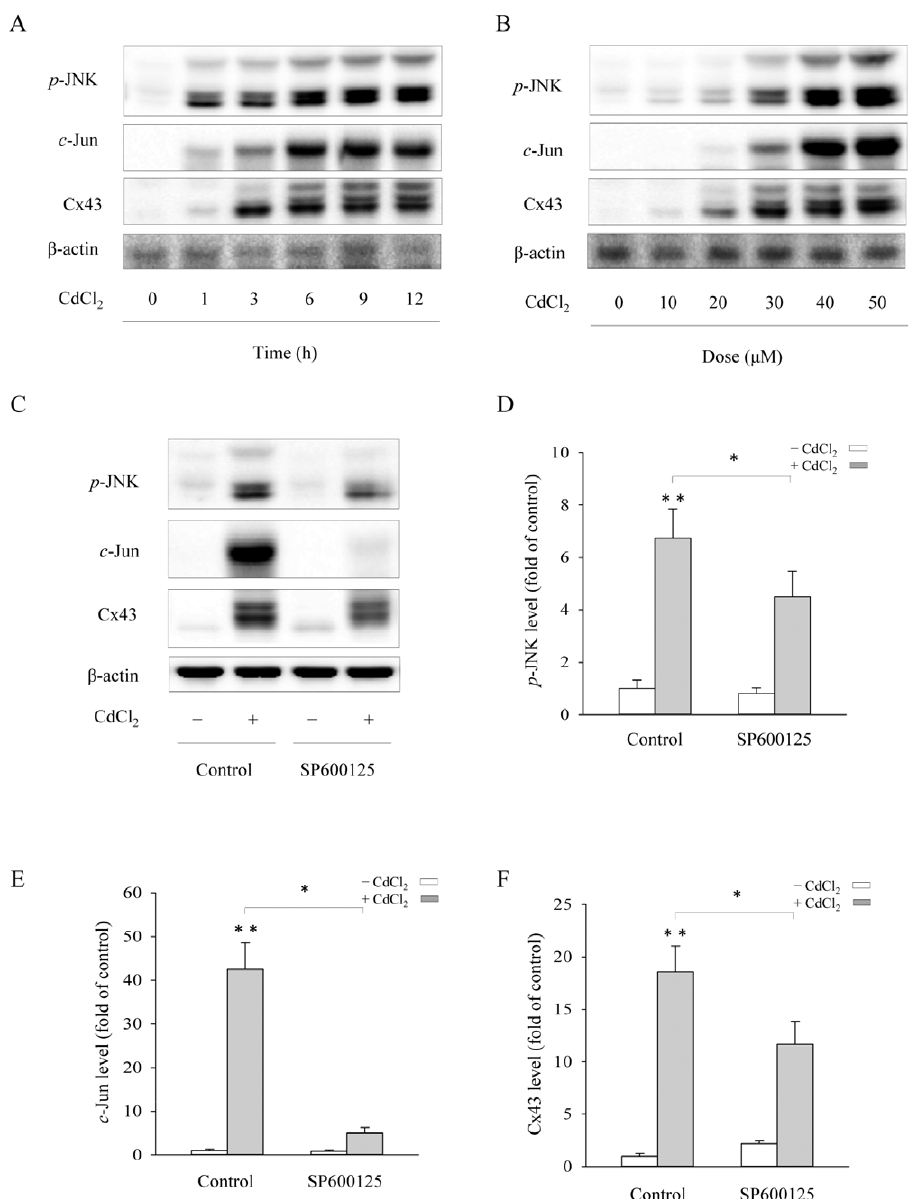
Figure 2. Involvement of JNK activation in the induction of Cx43 protein by Cd 2 + . (A–B) Cd 2 + -induced p -JNK and c -Jun activation. LLC-PK1 cells were exposed to 35 m M Cd 2 + for the indicated time (A) or various concentrations of Cd 2 + (B) for 6 h. The cellular protein was extracted and subjected to Western blot analysis of phosphorylated ( p ) JNK, c -Jun and Cx43. The level of b -actin was taken as loading control. (C–F) Suppression of Cd 2 + -elicited increase of p -JNK, c -Jun and Cx43 levels by a JNK inhibitor. LLC-PK1 cells were pretreated with 50 m M SP600125 for 30 min before exposing them to 35 m M Cd 2 + for 6 h. Cellular proteins were analyzed for p -JNK, c -Jun, Cx43 and b -actin (C). (D–F) Densitometric analysis of p -JNK, c - Jun and Cx43 expression shown in C. Results were expressed as relative induction compared with the basal level (mean 6 S.D., n=3). * p , 0.05 versus Cd 2 + alone, and ** , 0.01 versus untreated control.